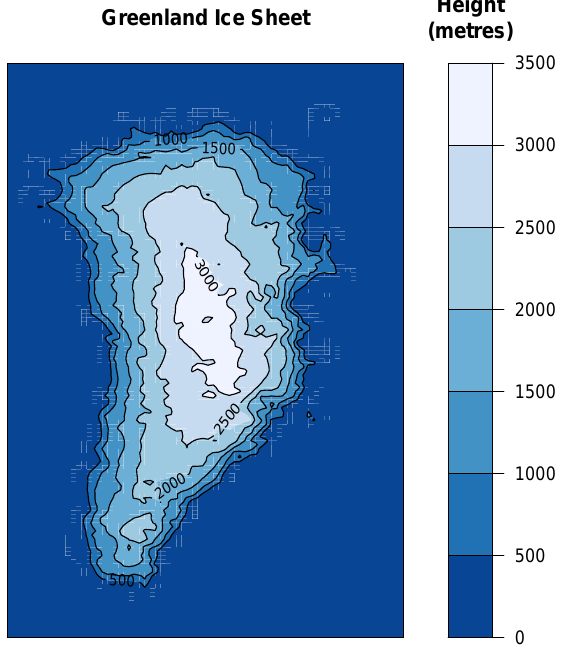
Fig. 1. Observations of ice sheet thickness over the Glimmer do- main, from Bamber et al.